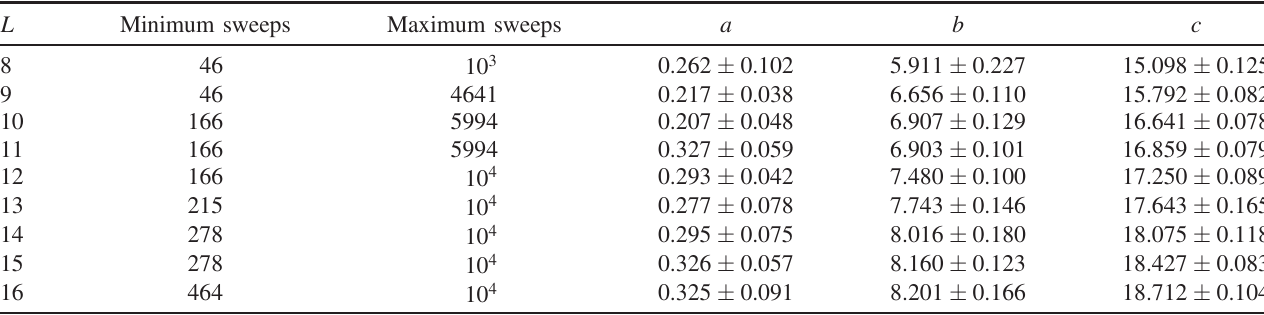
TABLE VII. Fit to y ¼ a ð x − b Þ 2 þ c for the median results of the hardware-planted instances using SAC with y ¼ log TTS and x ¼ log n . The factor c does not include f sweeps SAC